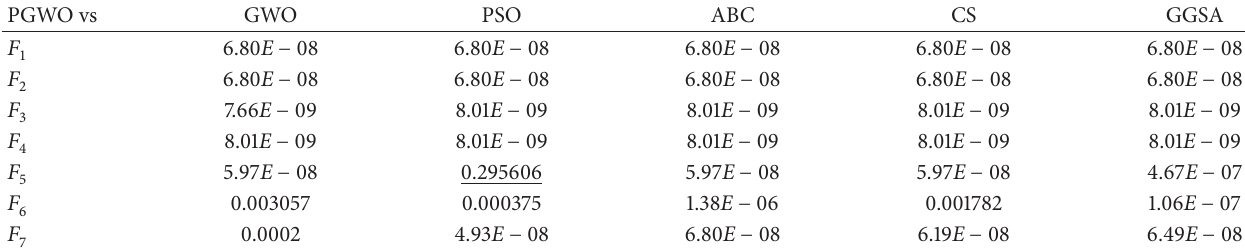
Table 4: 𝑝 values produced by Wilcoxon’s rank-sum test comparing PGWO versus GWO, PSO, ABC, CS, and GGSA over benchmark functions ( 𝑝 ≥ 0.05 have been